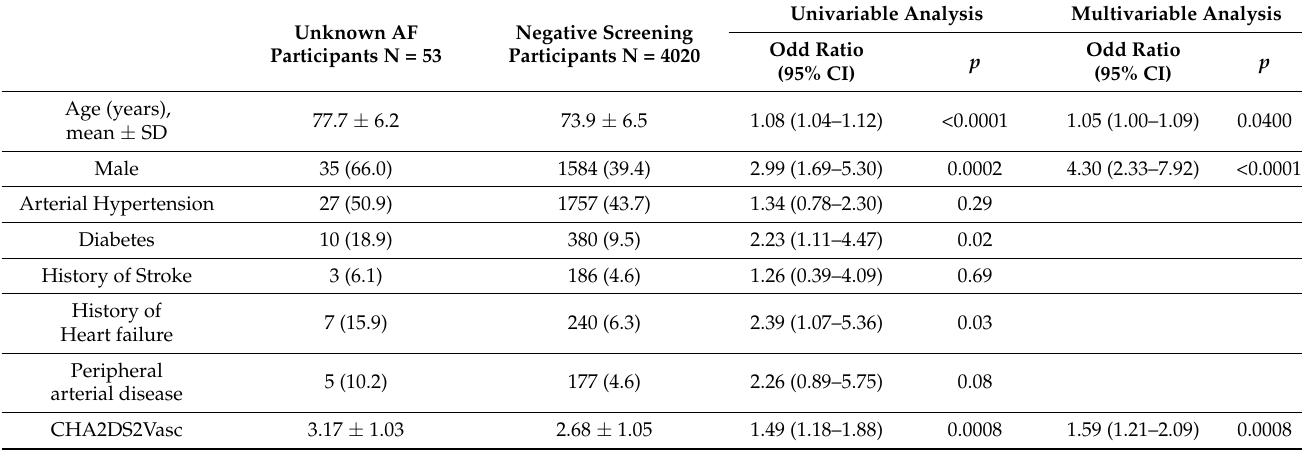
Table 3. Characteristics of positive screening with unknow AF and negative screening participants. Uni- and multi-variable